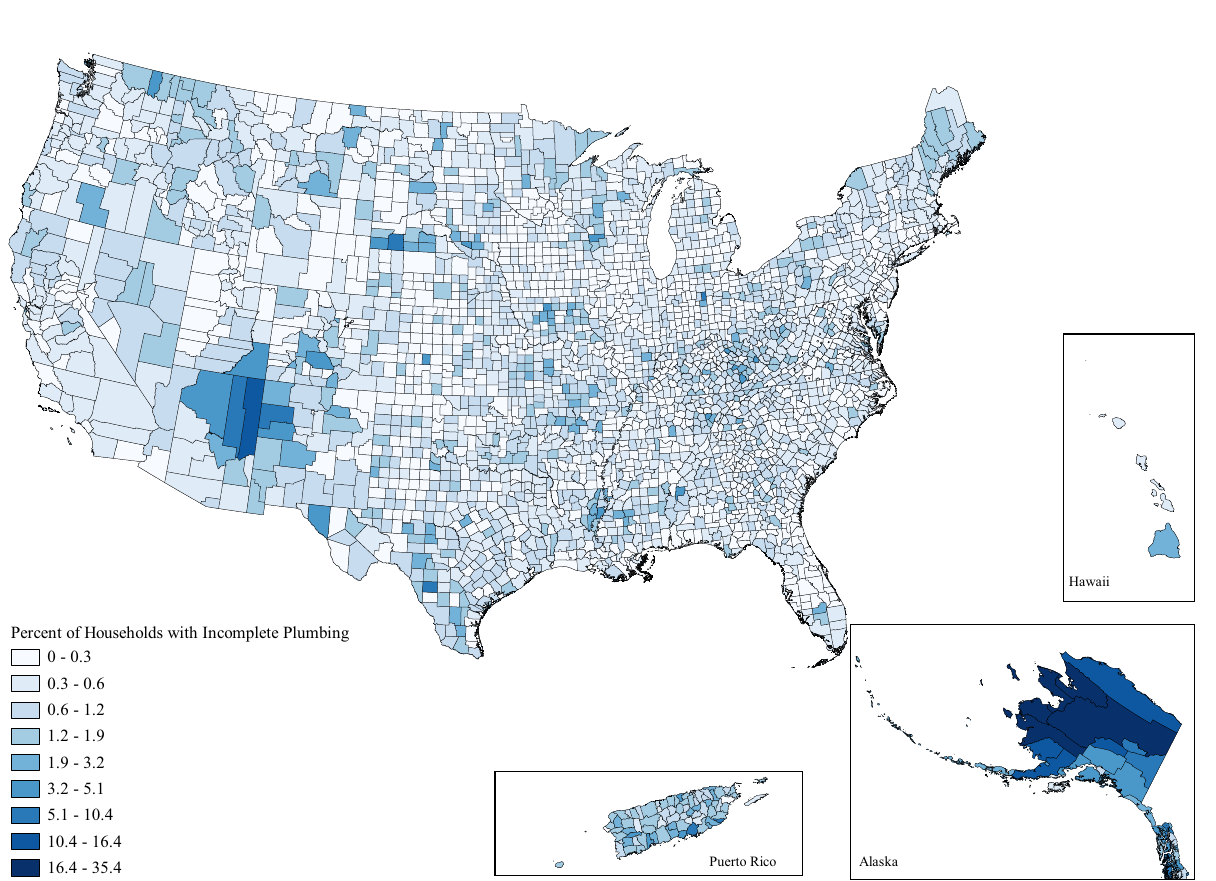
Fig. 1 Map of the percent of county households without full indoor plumbing as reported by the 2014 – 2018 American Community Survey. Households are determined to have incomplete plumbing if they do not have access to hot and cold water, a sink with a faucet, a bath or shower, and — up until 2016 — a fl ush